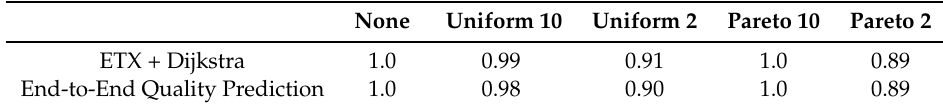
Table 3. Packet delivery ratio (PDR) with link